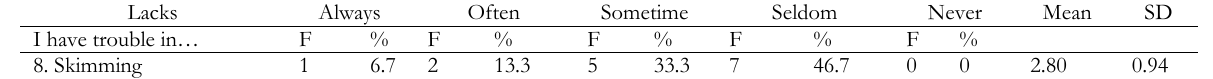
TABLE 7. P articipants’ perception of their reading difficulties.